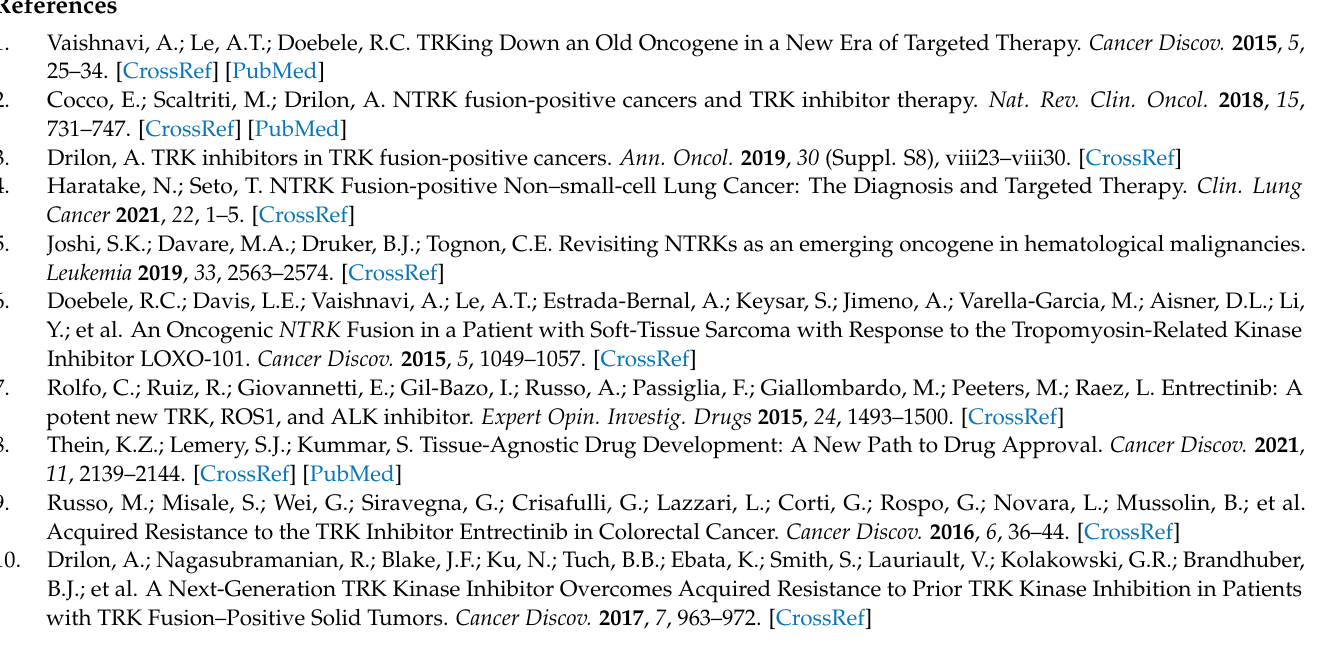
evaluated using a CCK-8 assay. The data were means from at least three independent experiments. Table S4. Pharmacokinetic parameters of JND4135 in rats. Figure S1. Effects of JND4135 on TRK signal pathway in BaF3 cells (6 h). Cells were treated with 0–200 nmol/L of JND4135 for 6 h, then harvested and lysed. Cell lysates were separated by sodium dodecyl sulfate-polyacrylamide gel electrophoresis (SDS-PAGE) and analyzed by Western blot. Figure S2. JND4135 effectively suppresses xDFG mutant TRK signal pathway in stable BaF3 models (6 h). Cells were treated with 8, 40 and 200 nmol/L of JND4135 for 6 h, then harvested and lysed. Cell lysates were separated by sodium dodecyl sulfate-polyacrylamide gel electrophoresis (SDS-PAGE) and analyzed by Western blot for p-TRK, p-PLC- γ 1 and p-Erk. GAPDH was used as a loading control. Figure S3. RMSD value of JND4135 with TRKA (A), TRKA-G595R (B), TRKA-G667C (C) and TRKA-V573M (D) proteins during the 500 ns MD simulations. Figure S4. Kinase inhibitory activities of JND4135 against TRKA, TRKB, TRKC and TRKA-G667C. TRKs activity experiments were performed using the FRET-based Z0-Lyte assay according to the manufacturer’s instructions. Movie S1. The unbinding process of JND4135 from TRKA G667C. Movie S2. The unbinding process of Larotrectinib from TRKA G667C. Author Contributions: J.W. performed the in vitro and in vivo experiments; Y.Z. performed the docking and dynamic simulations; X.T. performed BaF3 model construction and partly in vitro experiments; X.Y. performed in vitro experiments; Y.W. and S.C. performed the protein expression; Shingpan Chan synthesized the compound; X.S. and Z.T. performed the kinase activities assay; Z.Z. (Zhimin Zhang) supervised the protein expression; X.L. supervised the docking and dynamic simulations; Z.Z. (Zhang Zhang) and K.D. designed and supervised all the experiments, wrote and revised the paper. All authors have read and agreed to the published version of the manuscript. Funding: The authors are grateful for the financial support from National Natural Science Foundation of China (81973158, 22037003, 21572230 and 21702075), National Ministry of Science and